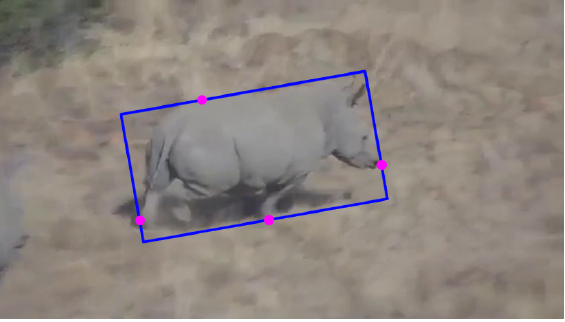
Figure 4. Reference rectangle of the ground truth. The reference rectangle has included all of the pixels of the tracked animal, and the pink points are key pixels for locating the reference